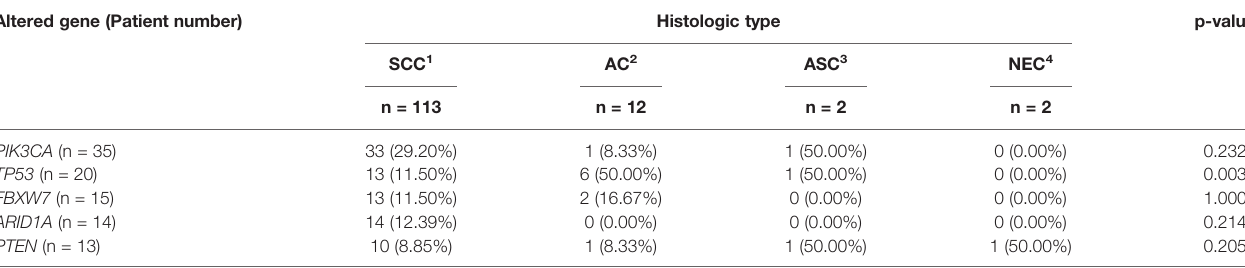
TABLE 2 | Genomic alterations in four histologic types among 129 cervical patients.